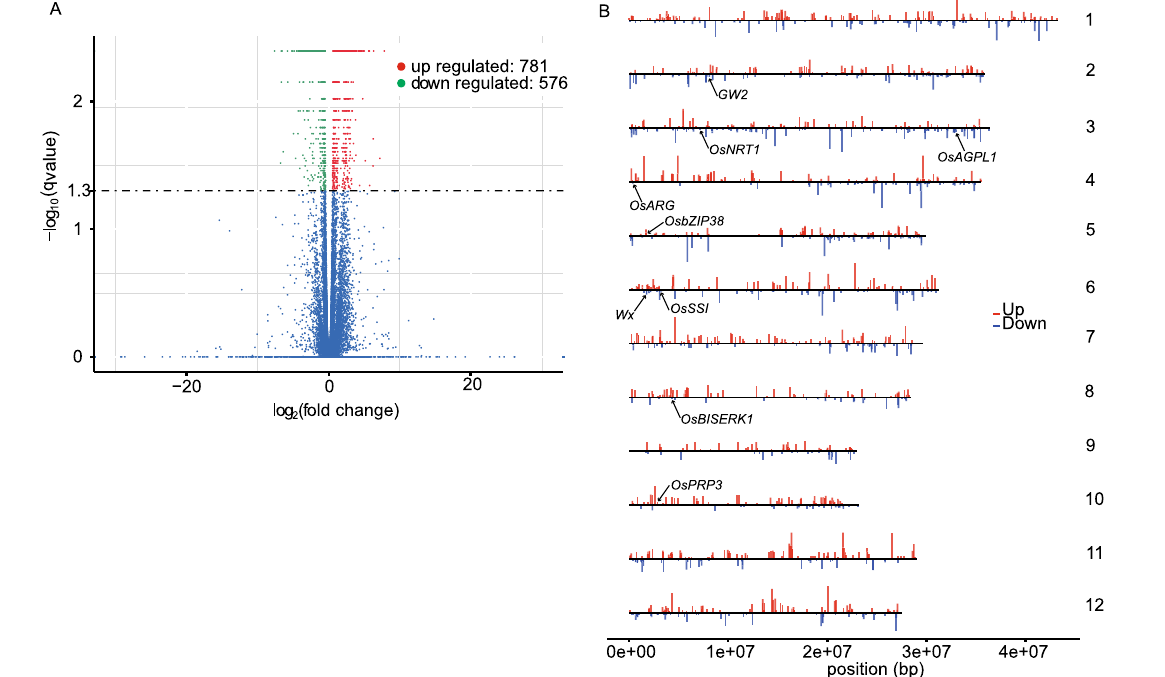
Figure 5. Summary of DEGs between indica and japonica rice. ( A ) Genes that were expressed at significantly different levels between indica and japonica rice. Red dots represent the up-regulated genes and green dots show the down-regulated genes. The blue dots represent non-DEGs. The volcano spots show 1357 unigenes, including 781 up-regulated unigenes and 576 down-regulated unigenes, which were identified as DEGs. ( B ) Distribution of the DEGs along rice chromosomes. The maps (A, B) were created in R (v.3.2.1; https ://www.r-proje